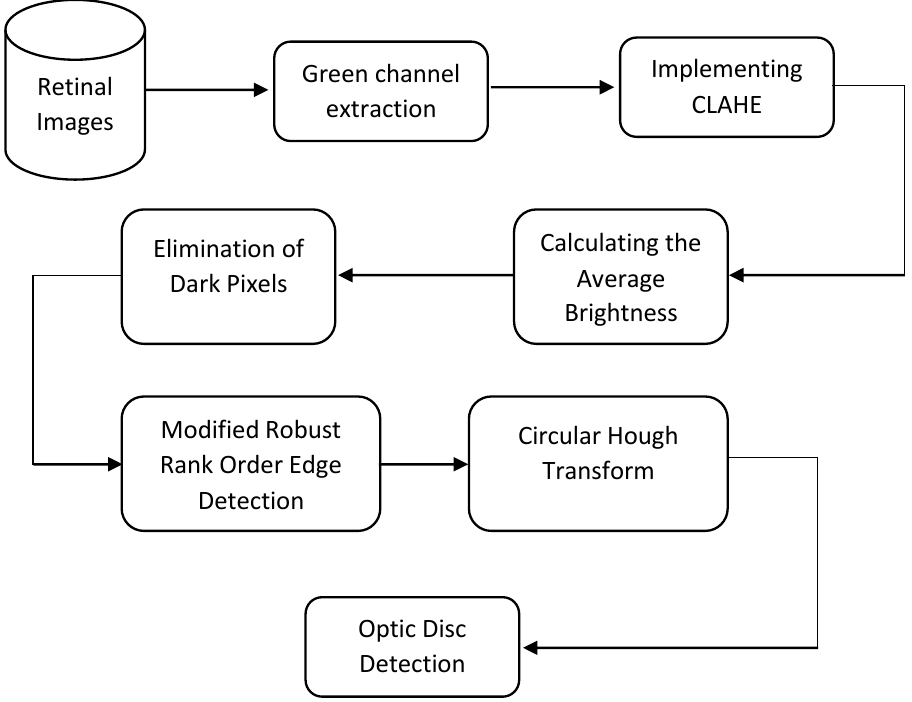
Figure 2. Main steps of the proposed method. CLAHE: contrast-limited adaptive histogram equalization.